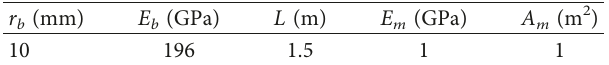
Table 9: Mechanical properties of the bolt and the confining medium.